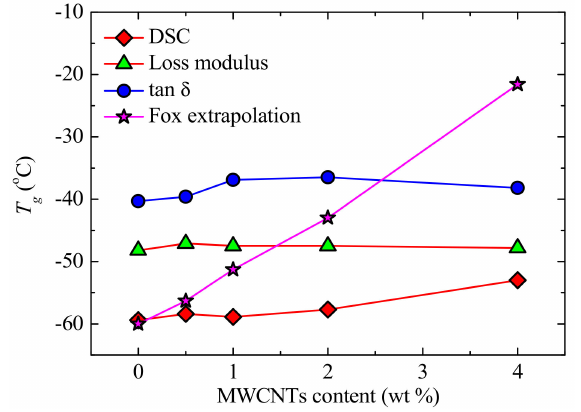
Figure 6. Glass transition temperatures of neat PCL and the PCL/(PC/MWCNT) nanocomposites as a function of MWCNT